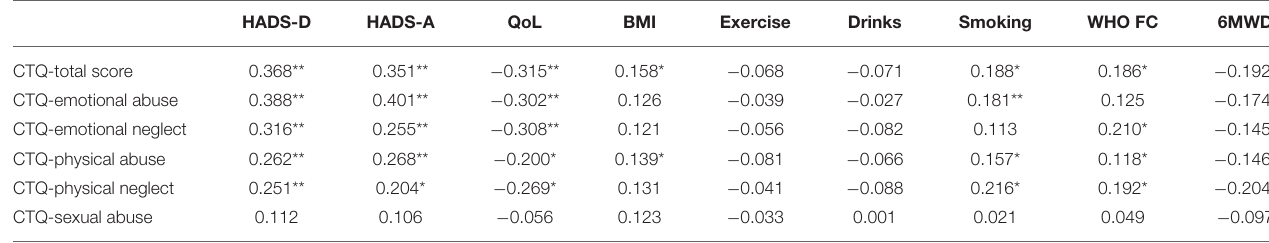
TABLE 3 | Correlations of CTQ-scores in PAH with HADS, QoL, Lifestyle and 6MWD, and WHO FC. HADS-D HADS-A QoL BMI Exercise Drinks Smoking WHO FC 6MWD CTQ-total